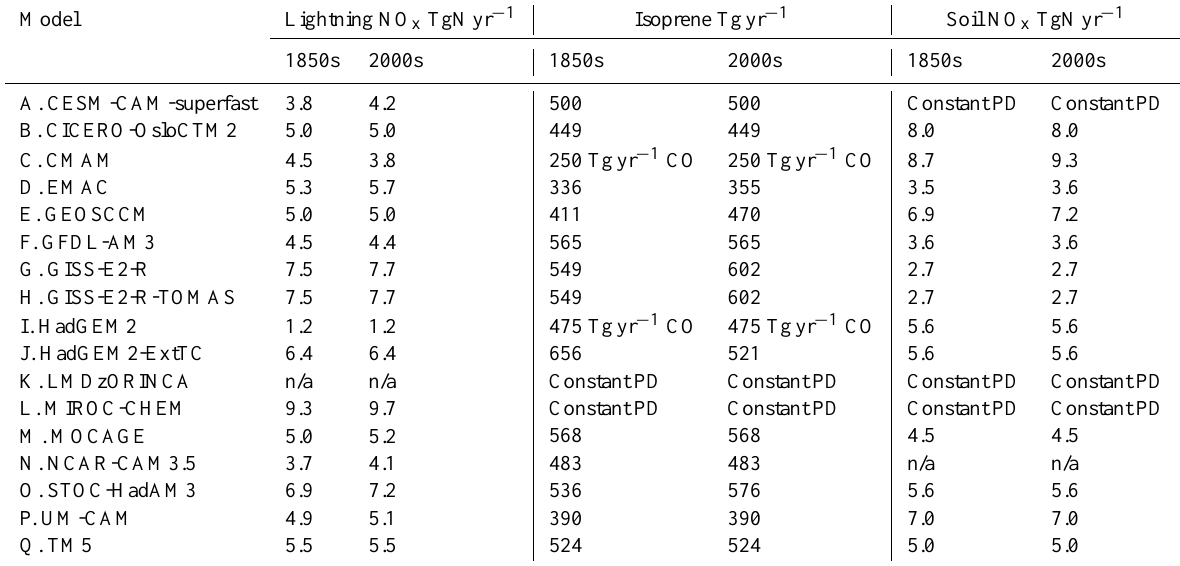
Table 2. Natural emissions (lightning NO x , biogenic isoprene, soil NO x ) in 1850s and 2000s. Two models (C and I) that did not include isoprene in their chemical schemes included surrogate emissions of CO. Some values are not available (n/a); where values are not available, but models ran with constant present-day (PD) values, this is